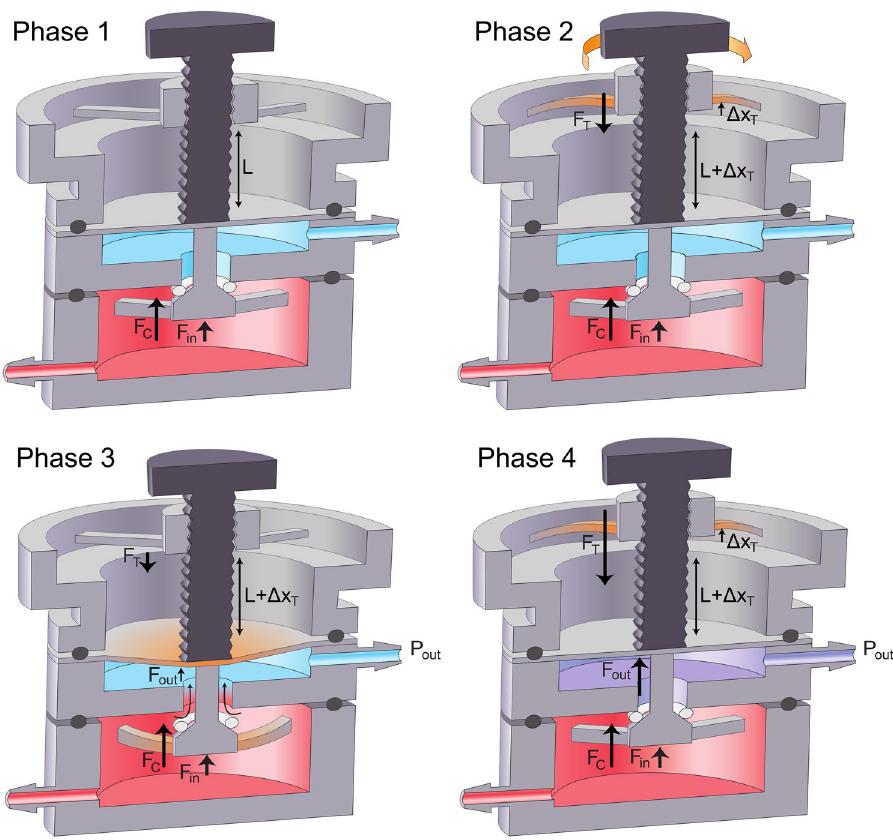
Figure 3. Depiction of the four phases of the pressure regulating process. During Phase 1, the air passage is fully closed, while we supply air from a constant high pressure source. In Phase 2, the user turns the control knob to displace the top cantilevers. As the top cantilever restoring force (F T ) increases, the air passage between the chambers remains closed. In Phase 3, when F T surpasses a threshold value, the air passage opens. Finally, in Phase 4, the pressure in the low-pressure air chamber reaches the desired level set by the position of control knob and the passage will close. Once the pressure is set by the user, the device cycles between Phase 3 and Phase 4 to maintain the desired output